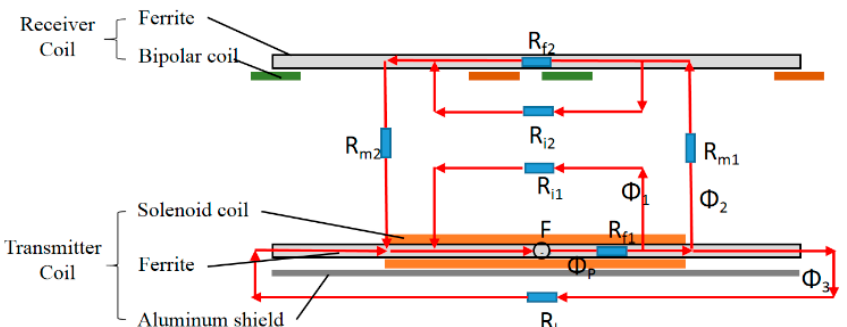
Figure 6. Flux distribution of the proposed transformer structure.